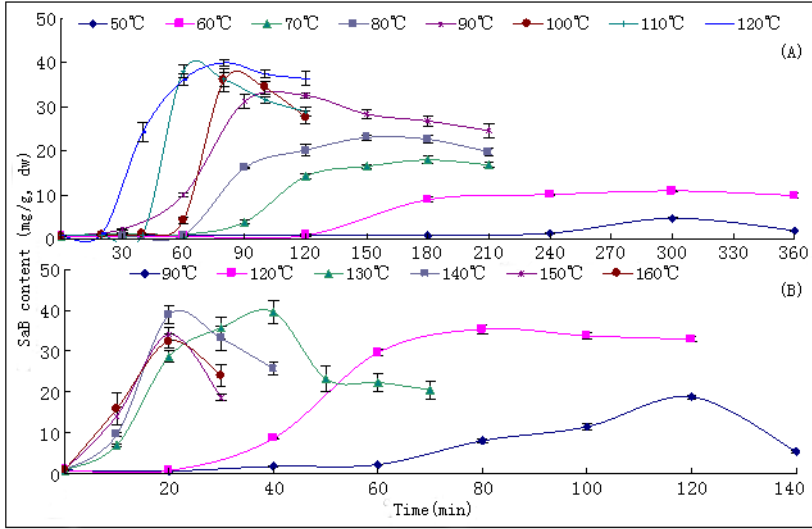
Figure 4. Production and variation curves of salvianolic acid B in Danshen during the drying process at different temperature. ( A ) results of experiment 1; ( B ) results of experiment 2.